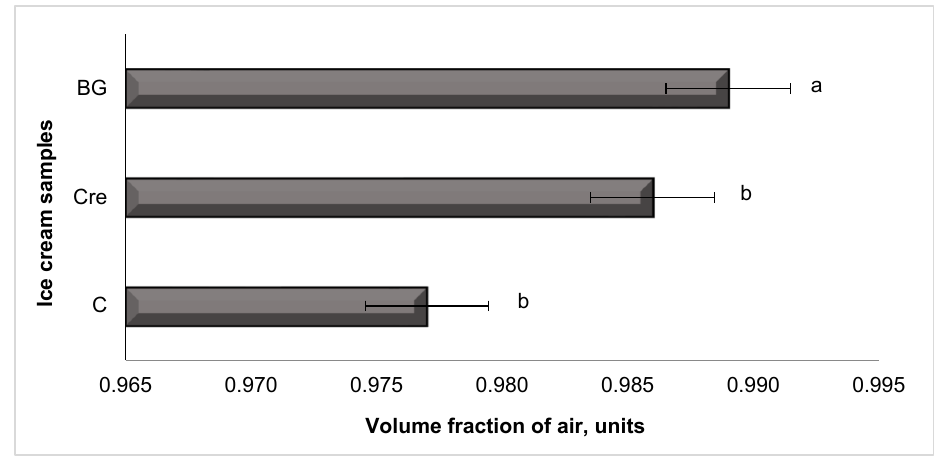
Figure 2. Volume fraction of air in ice cream after freezing, units: C is low-fat milky ice cream without stabilizer (control); Cre is low-fat milky ice cream with 0.5% of Cremodan ® SI 320; BG is low-fat milky ice cream with 0.5% of oat β -glucan; a,b mean values denoted by different letters in the column differ significantly at p ≤ 0.05.